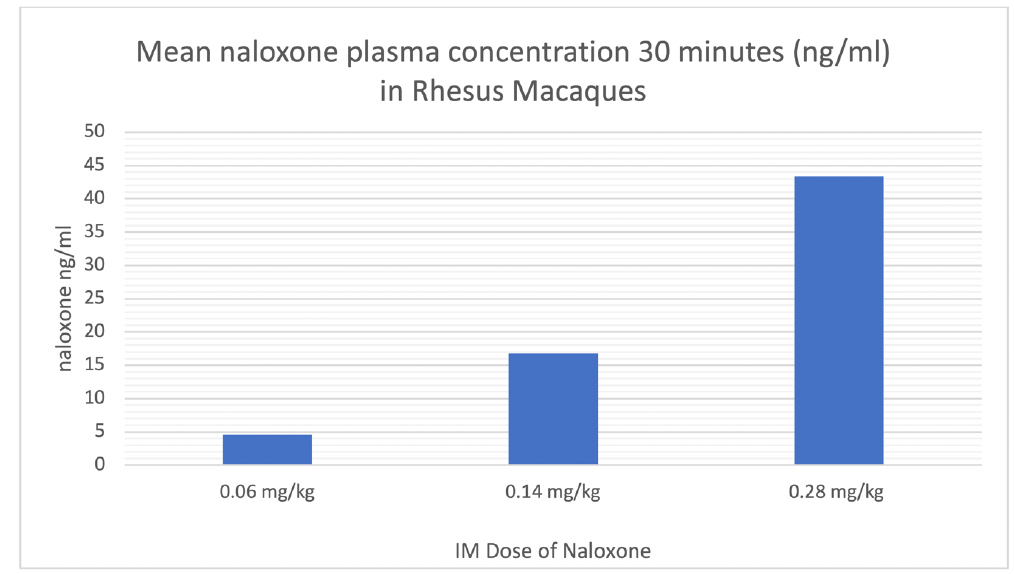
Molecules 2020 , 25 , x Figure 3. Plasma NLX levels 30 min after three different IM doses. Figure 3. Plasma NLX levels 30 min after three di ff erent IM doses.